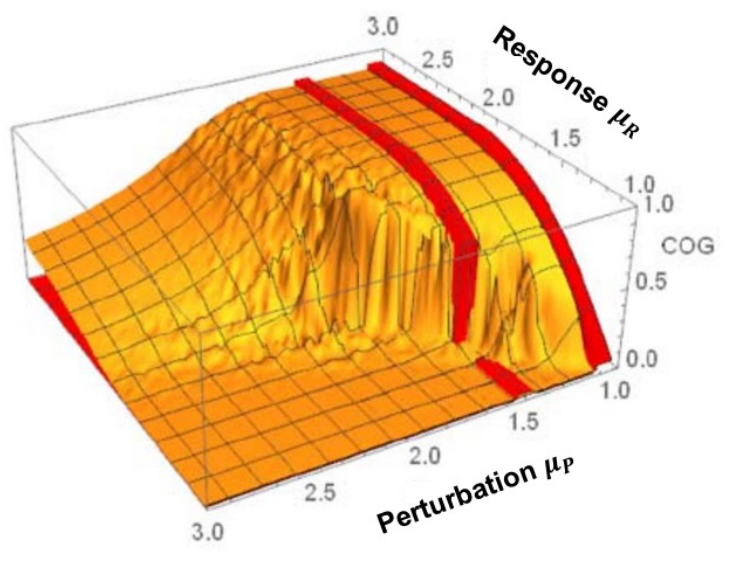
Figure 7. Non-ergodic complexity management CCC: The asymptotic in time cross-correlation function between the P and R networks as a function of the IPL indices. The details of the numerical analysis are given in [41], as are the analytic calculations given by the red